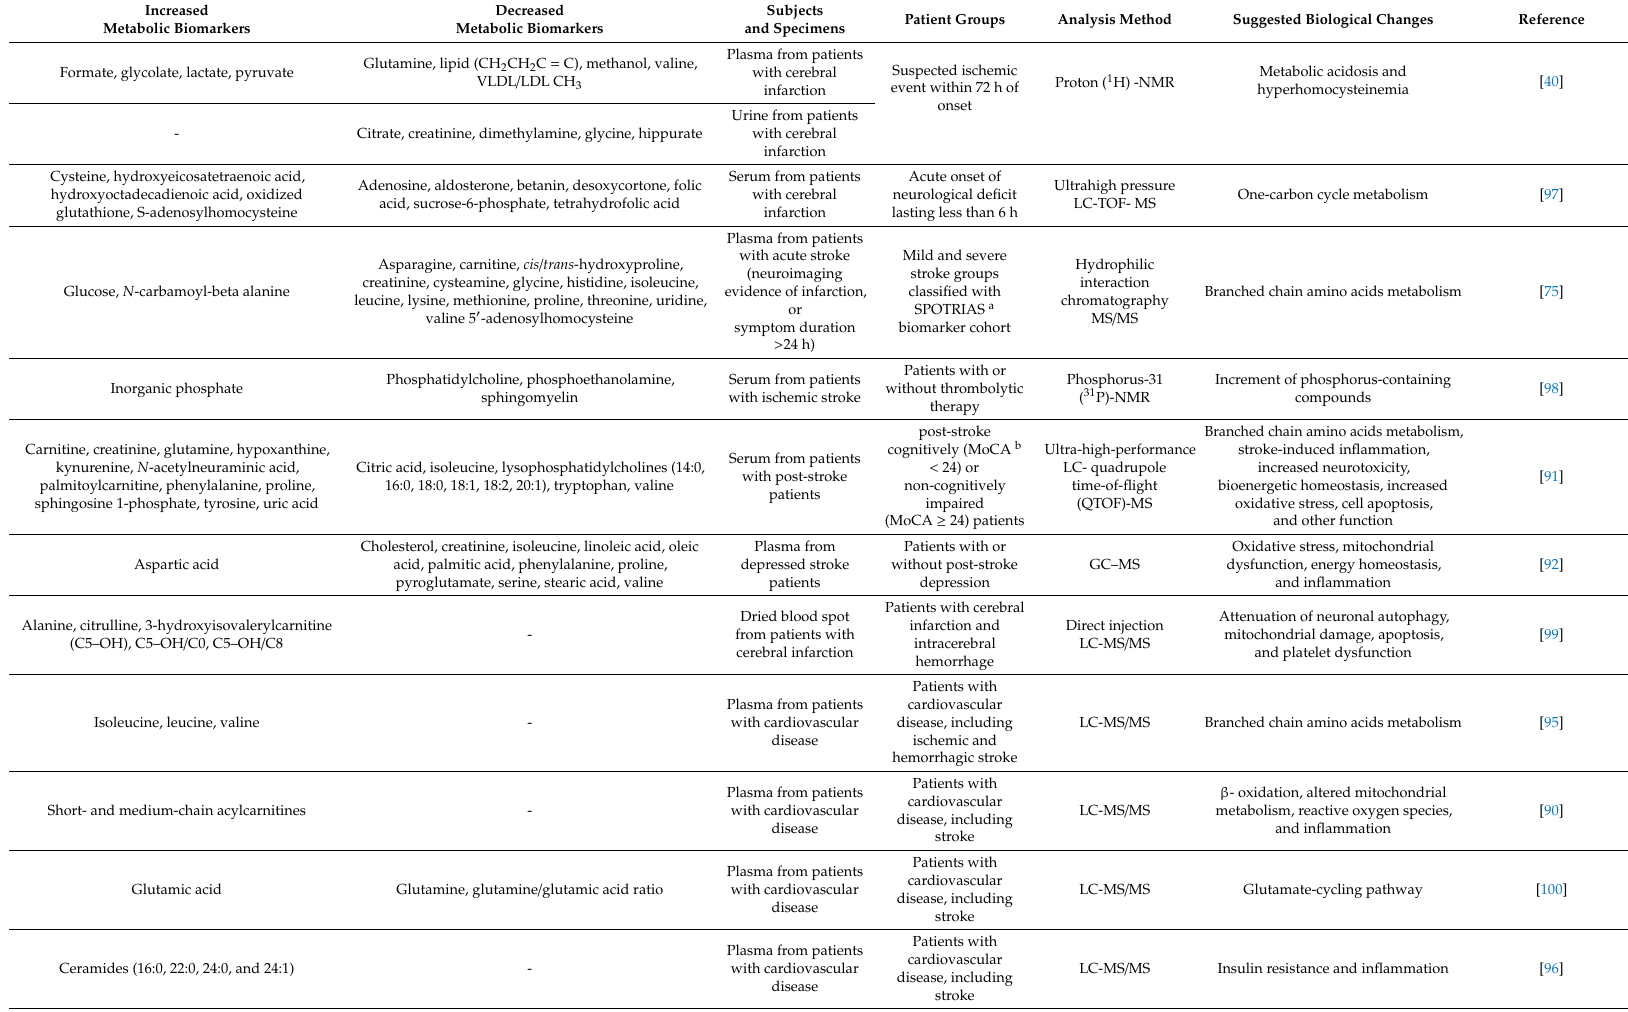
Table 1. Summary of metabolites associated with cerebral ischemia in